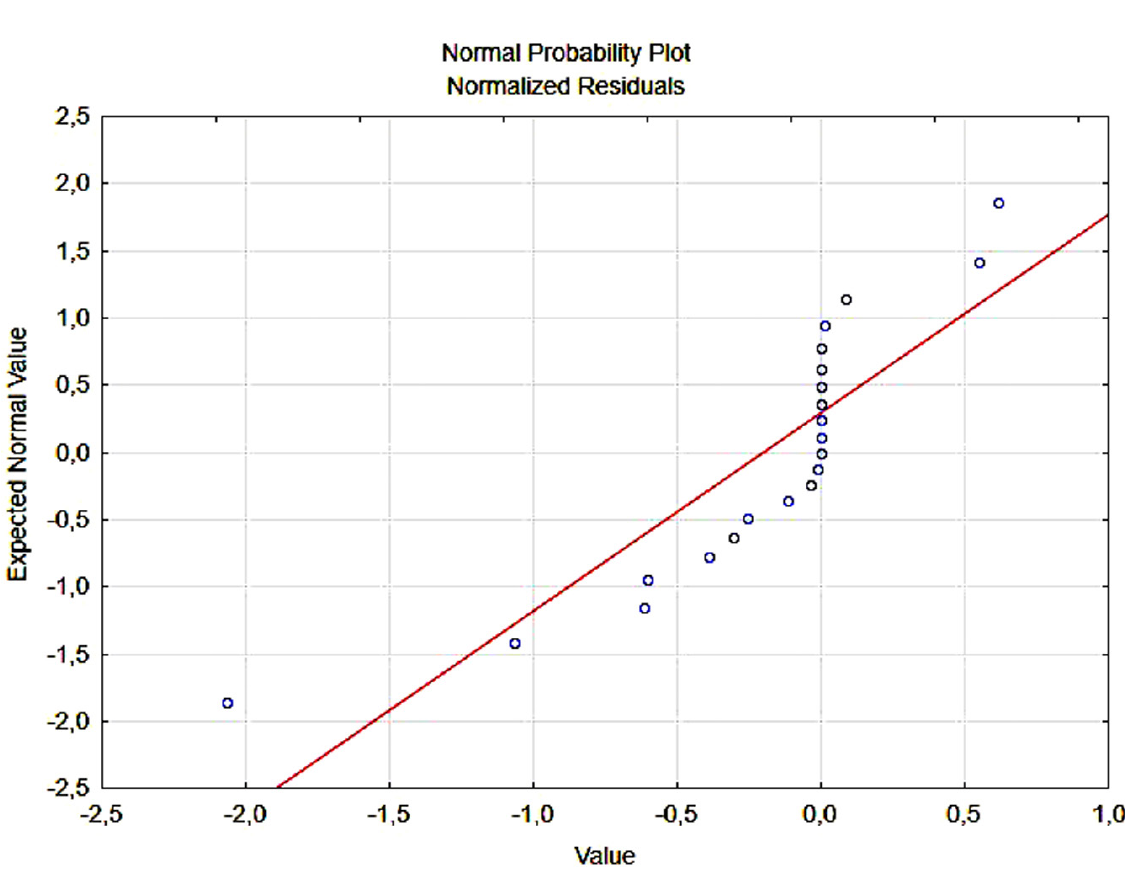
Figure 1. Verifying the model of the relationship between indicators of the business lending sector, the efficiency of business entities and their capital